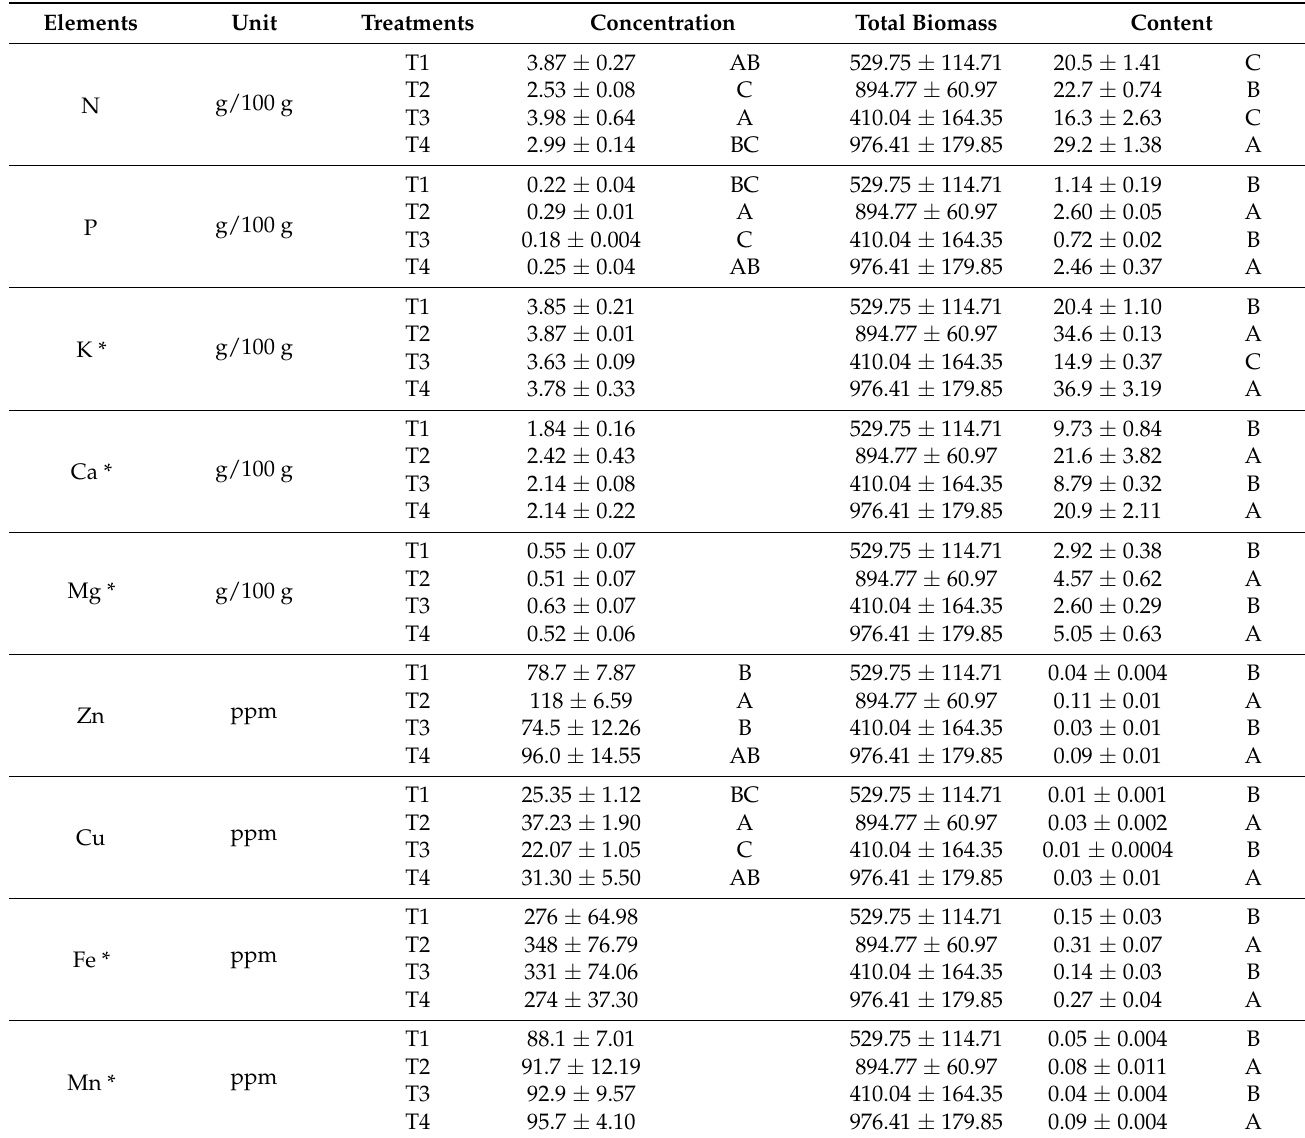
Table 6. Concentration and content of macro and micronutrients in pepper plants. Different letters indicate statistical differences between treatments (Tukey-HSD, α = 0.05) T1: without mulch + 251 mm of water; T2: with mulch + 251 mm of water; T3 without mulch + 129 mm of water; T4: with mulch + 129 mm of